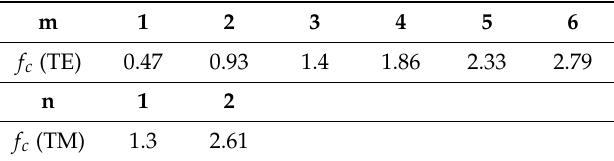
Table 1. The cutoff frequencies of TE m1 and TM 1n modes (GHz).